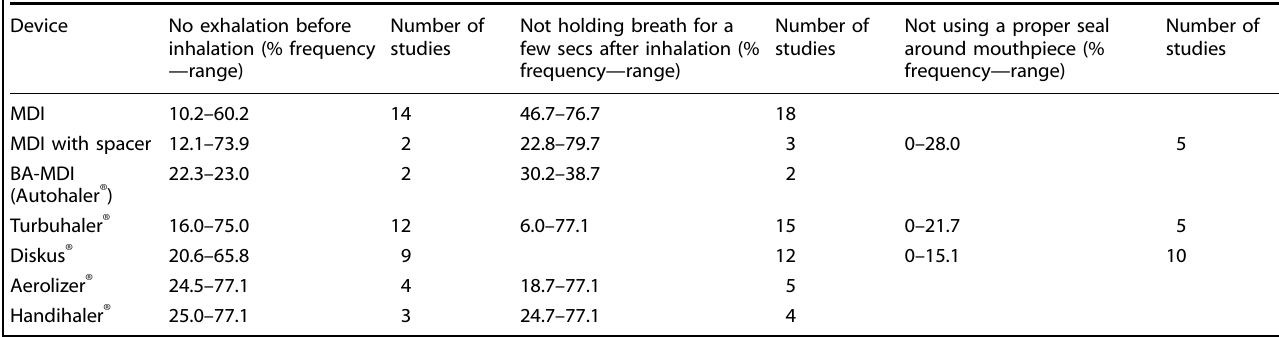
Table 2. Most common overall errors reported for each device